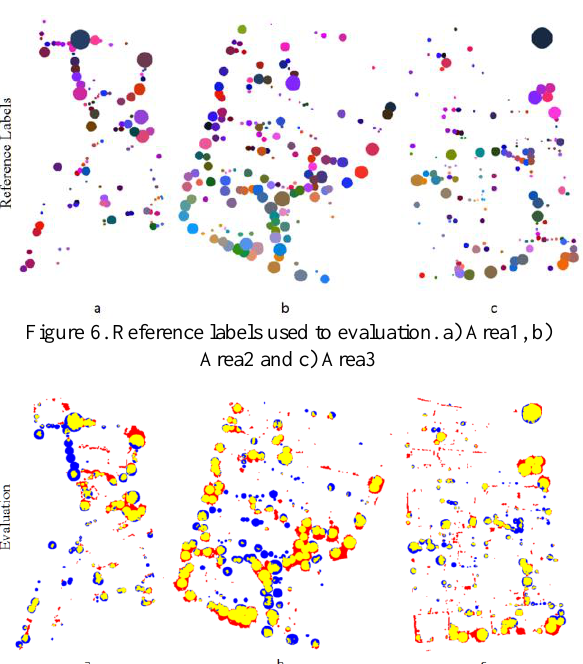
Table . Comparing results whit WG III/4 participants.